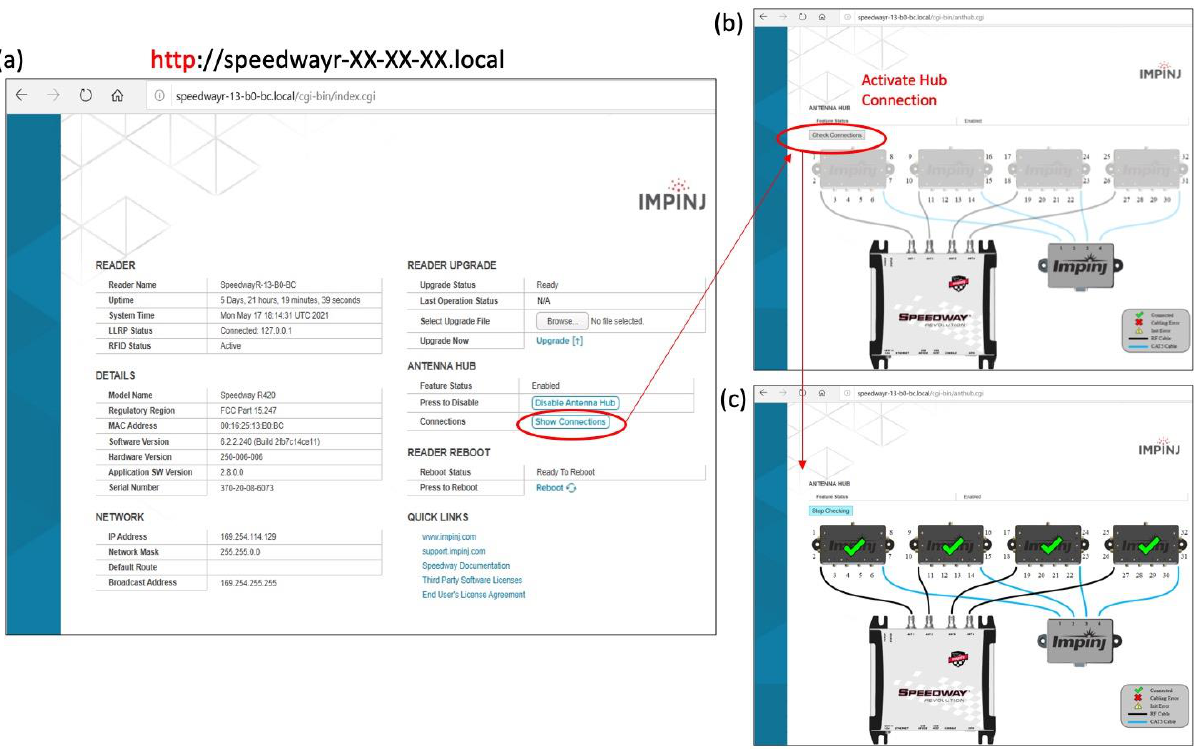
Figure 4. Accessing the primary reader’s webpage for parameter changes and activation of connected hubs prior to operating the unit. ( a ) shows the reader webpage address, location where the Speedway Connect software is uploaded, ( b ) interface of hub connectivity, and ( c ) confirmation page of all hubs’ proper connectivity.